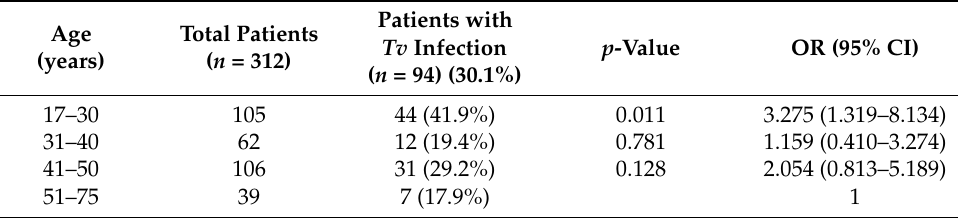
Table 2. Age distribution of Trichomonas vaginalis infection among all patients with vaginitis.